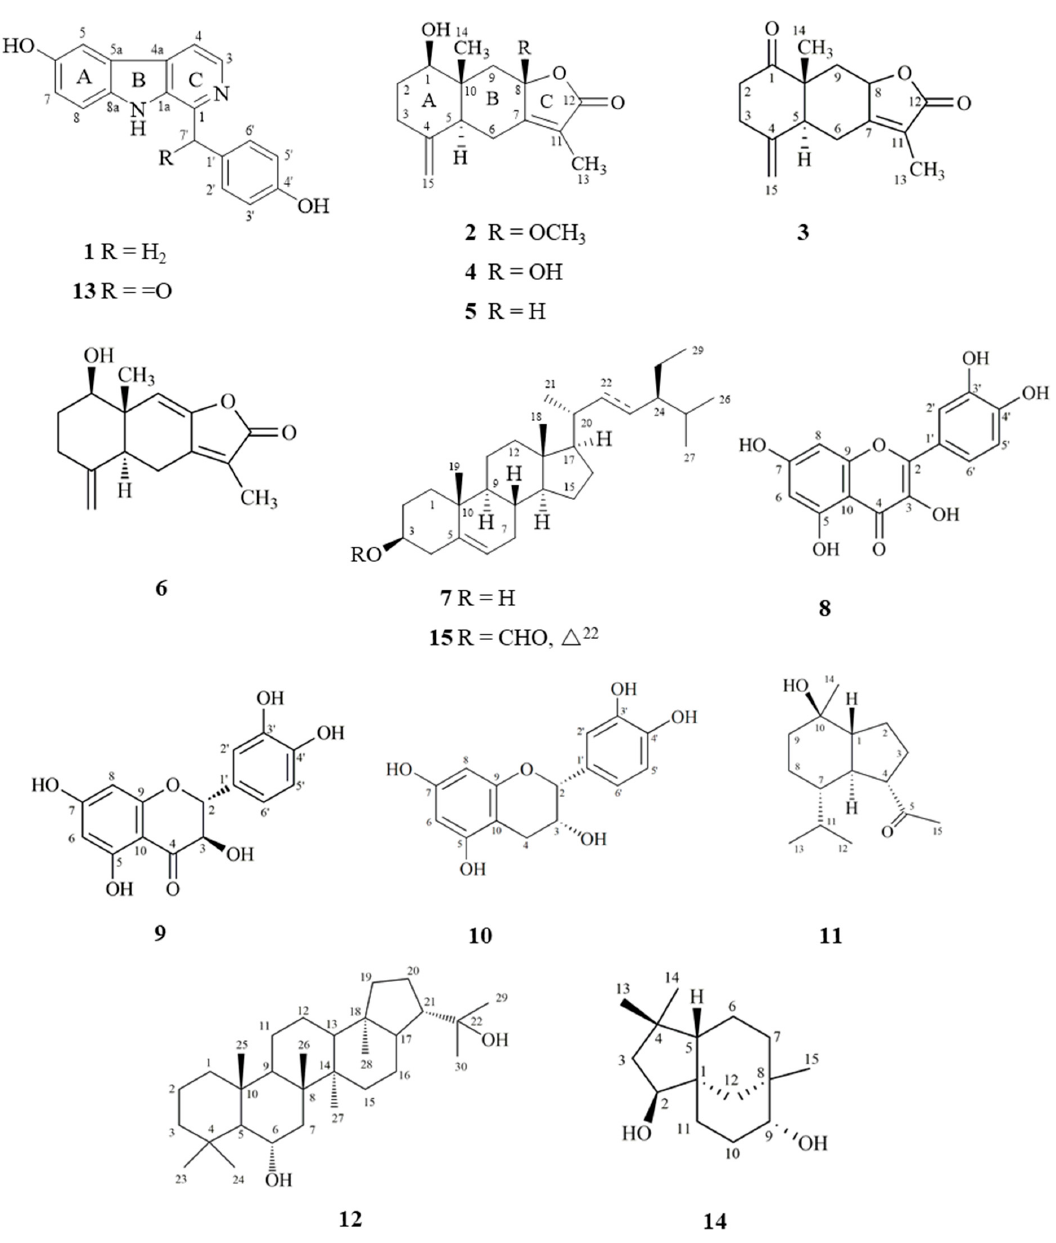
Figure 1. Structures of compounds ( 1 – 15 ) isolated from the root of Neolitsea acuminatissima. The UV spectrum of 1 was similar to that of daibucarboline A [4] and cecilin [20] and was consistent with a carboline moiety [20]. The 1 H-NMR spectrum of 1 (Table 1) showed a trisubstituted aromatic ABX system ( δ 7.10 (1H, dd, J = 8.8, 2.4 Hz, H-7), 7.40 (1H, d, J = 8.8 Hz, H-8), 7.56 (1H, d, J = 2.4 Hz, H-5)) on ring A, an NH proton ( δ 10.32 (1H, br s)) on ring B, a pair of mutually coupled protons ( δ 7.82 (1H, d, J = 5.2 Hz, H-4) and 8.24 (1H, d, J = 5.2 Hz, H-3)), and a p -hydroxybenzyl